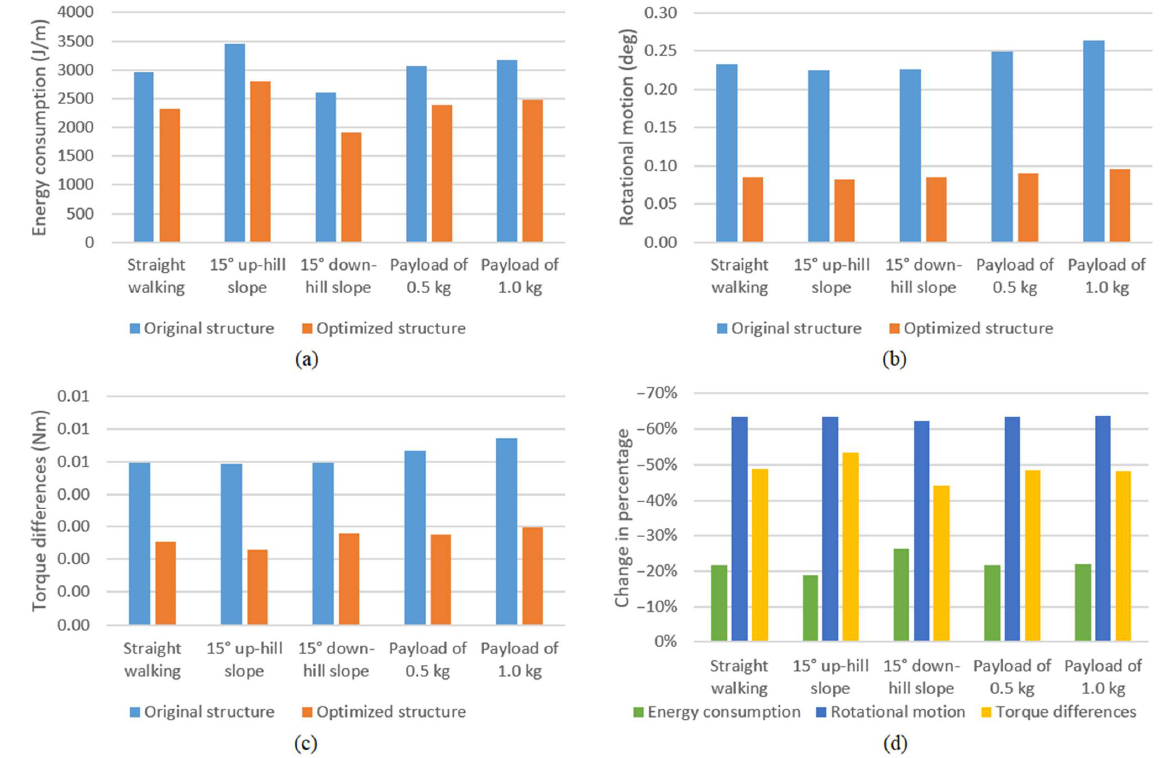
Figure 8. Performance results for the independent simulation scenarios. ( a ) Energy consumption. ( b ) Rotational motion. ( c ) Torque differences. ( d ) Change in percentage.